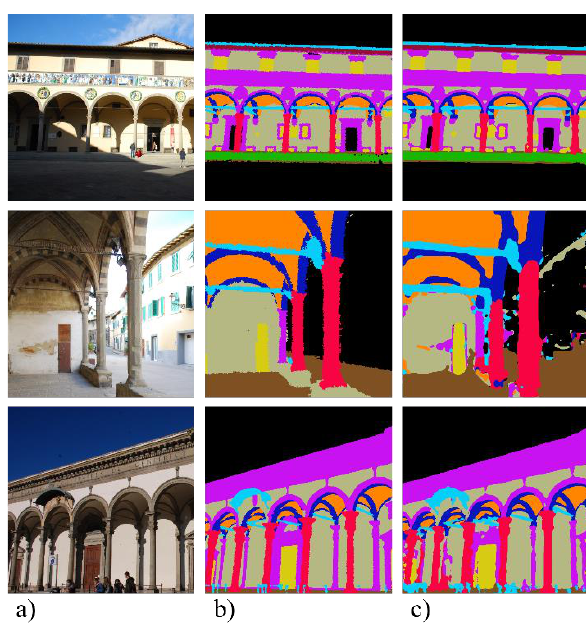
Figure 3 . DeepLablv3+ image semantic segmentation results on the test sets: a) input RGB images, b) ground truth, c) prediction.